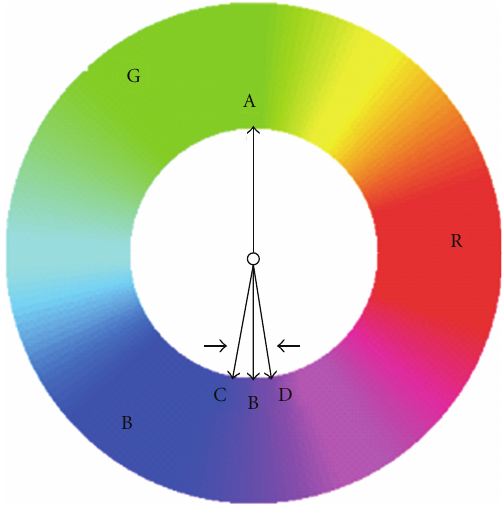
Figure 2: The complementary pleasant colors on the color wheel ((A): a sample color of overall averaged summation of the image background colors, (B): the rigid opposite color, (C): a cooler analogous color, and (D): a warmer analogous